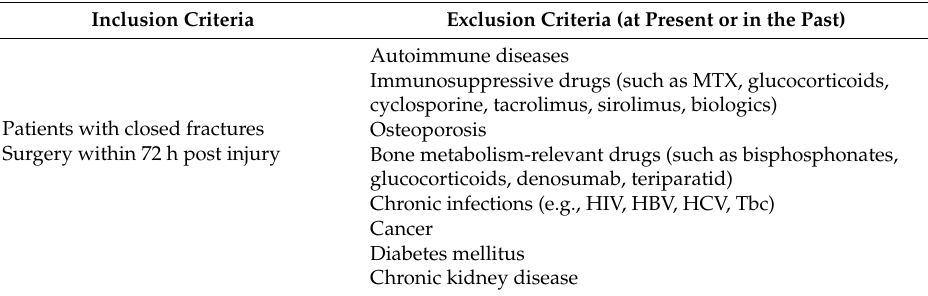
Table 1. Inclusion and exclusion criteria for patients defined as controls.